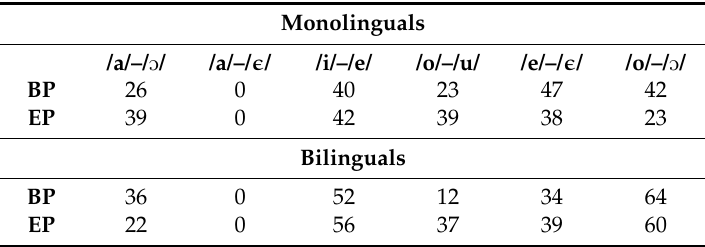
Table 4. Perceptual overlap scores for monolinguals and bilinguals across the six EP and BP contrasts in percentages.